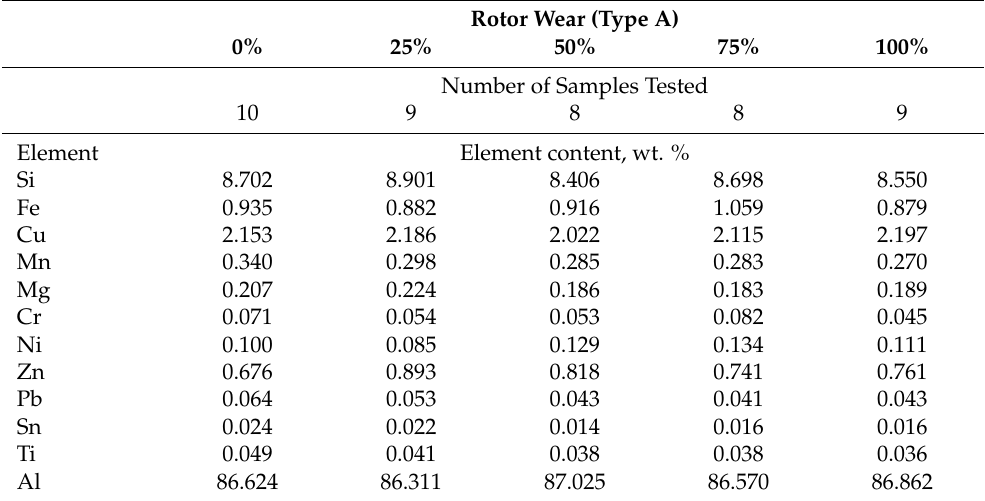
Table 7. Average chemical composition of samples taken from melts during operational experiments—type A rotor.